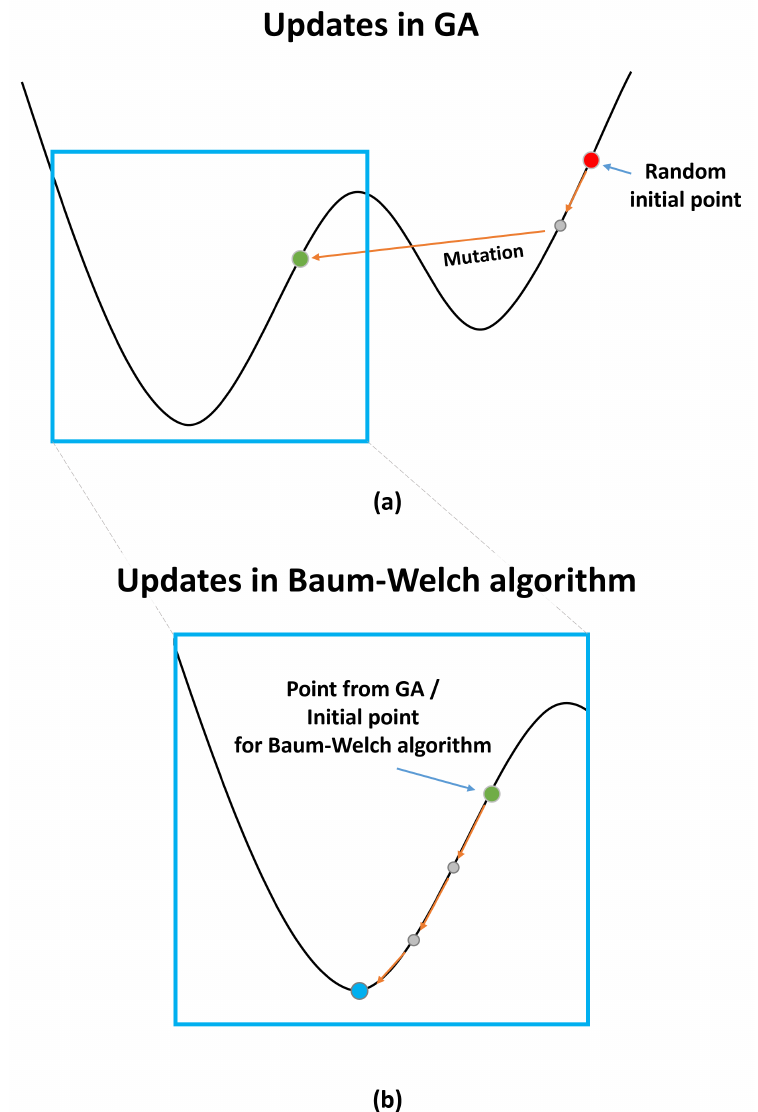
Figure 3. Parameters in HMM evaluated via sequential usage of GA and Baum–Welch algorithm: ( a ) GA yielded unbiased initial point for Baum–Welch algorithm in subsequent stage; ( b ) Baum–Welch algorithm yielded global optimal point from unbiased initial